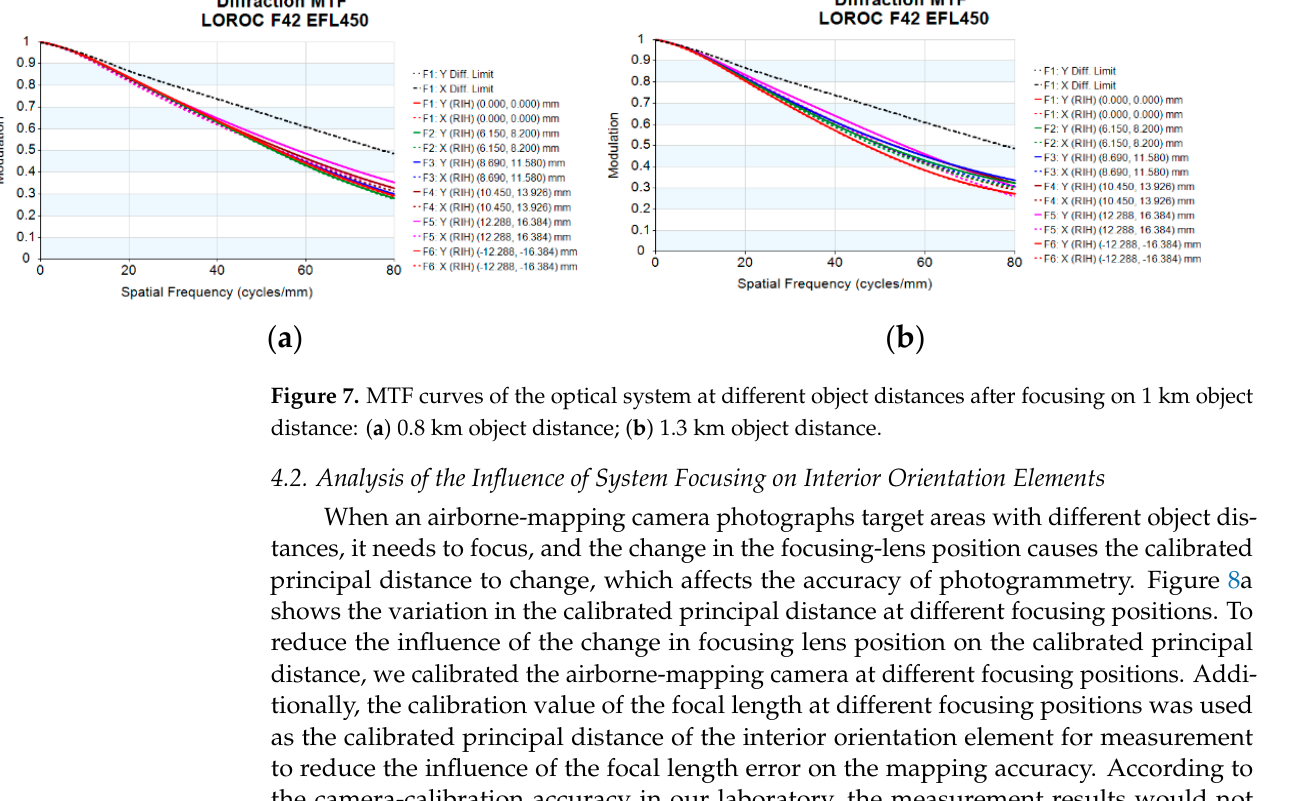
Figure 6. MTF-defocus amount curves of the optical system (80 lp/mm).